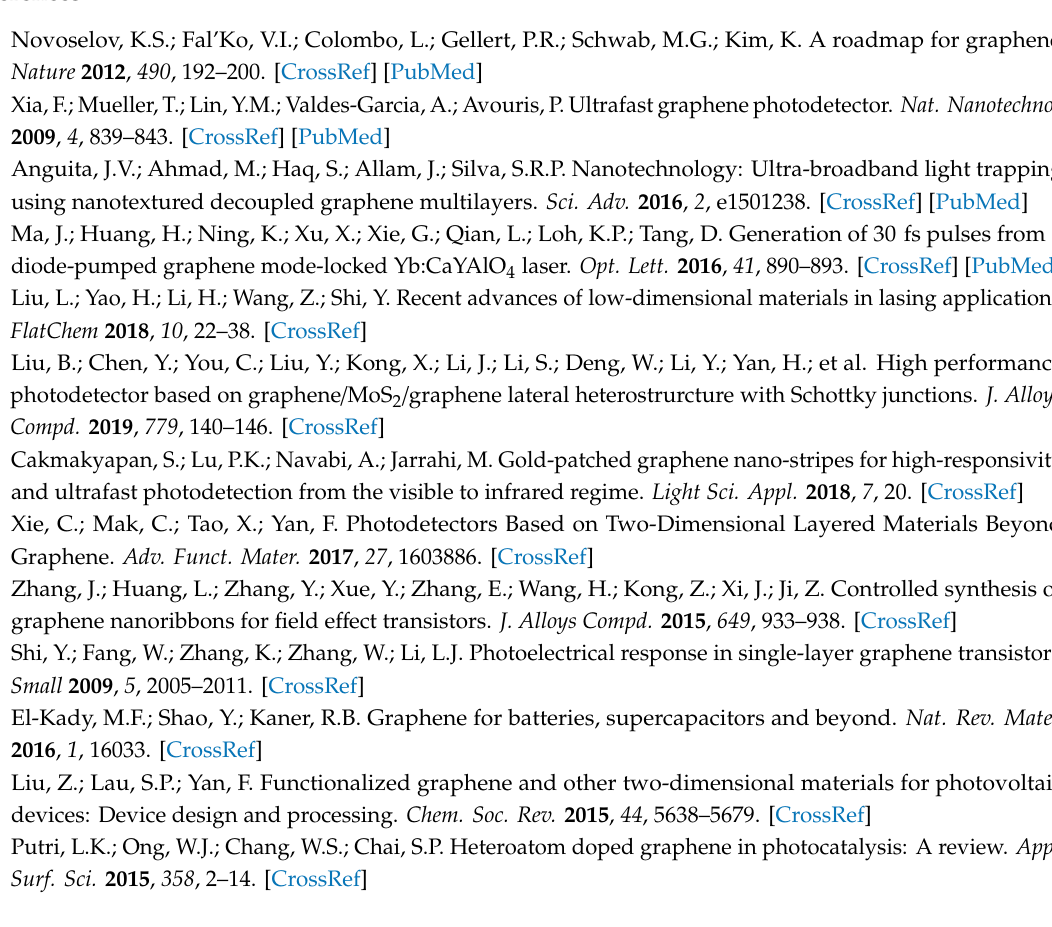
Figure S1: top-view SEM image of pristine SnS 2 film on FTO prepared at 60 ◦ C for 0.5 h, Figure S2: AFM height image of (a) pristine SnS 2 film and (b) SnS 2 / graphene heterostructure film on FTO prepared at 60 ◦ C for 1 h, Figure S3: top-view SEM image of SnS 2 / graphene heterostructure film, Figure S4: I-V curves of SnS 2 / graphene photodetector under vacuum and ambient